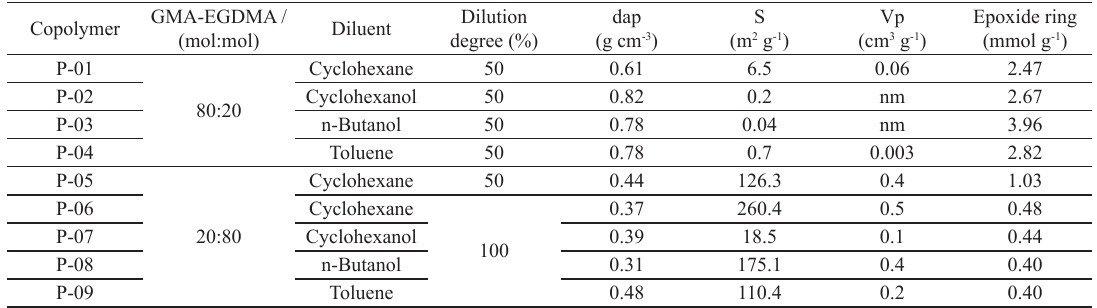
Table 1. Data of apparent density, specific area, pore volume to GMA-EGDMA copolymers GMA-EGDMA / Copolymer (mol:mol)